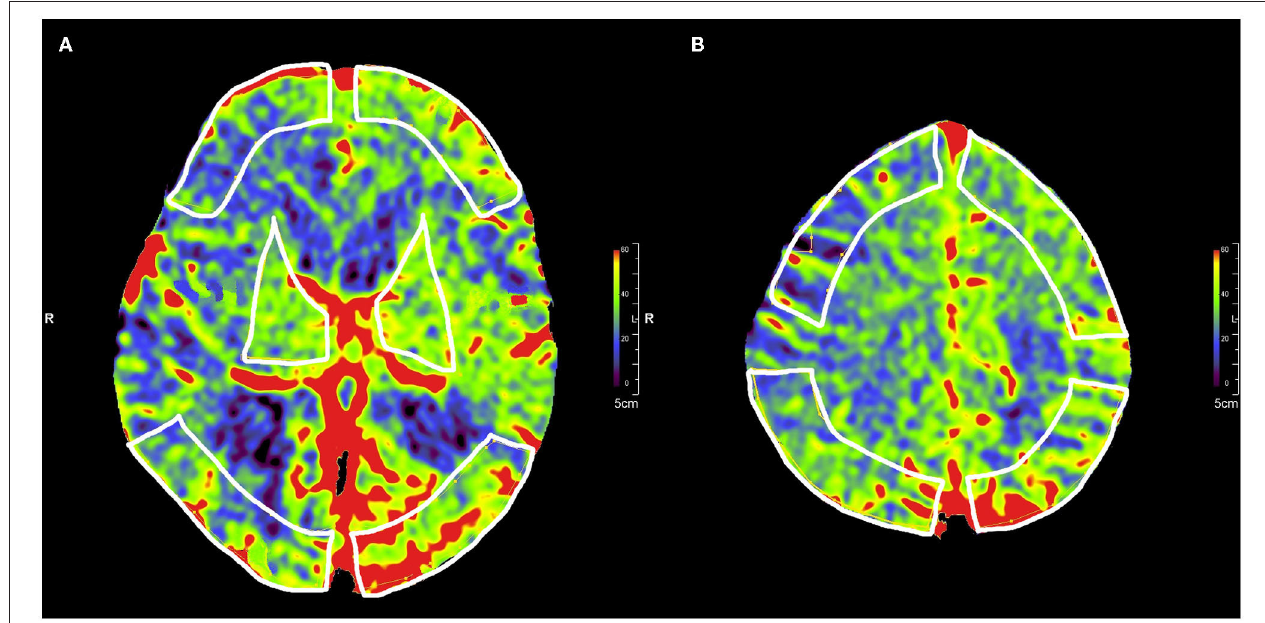
FIGURE 1 | Selection of five symmetrical ROIs in color-coded parenchymal blood volume maps. (A) ROIs of the frontal pole cortex, the occipital cortex, and the basal ganglia in the third ventricle level. (B) ROIs of the frontal cortex and the parietal cortex at 4.5cm above the third ventricle level.